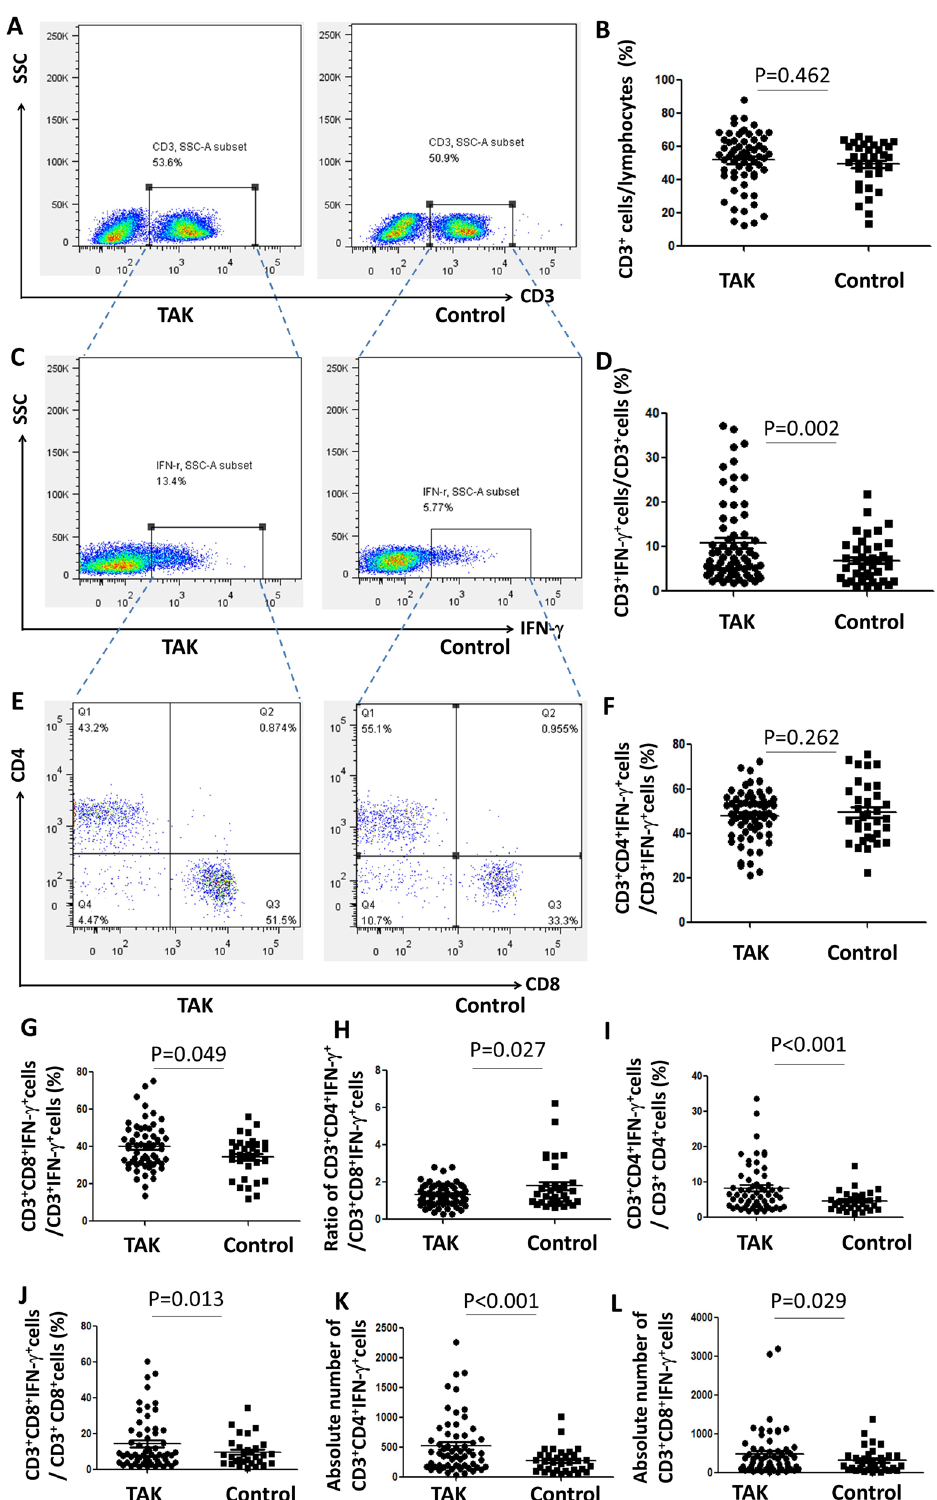
Figure 2. Comparing the proportions of CD3 + CD8 + IFN-γ + cells in CD3 + IFN-γ + cells between the TAK group (n = 60) and the control group (n = 35). ( A,B ) The proportion of CD3 + cells in lymphocytes in TAK group and control group ( P = 0.462). ( C,D ) The proportion of CD3 + IFN-γ + cells in CD3 + cells in TAK group and control group ( P = 0.002). ( E–G ) The proportion of CD3 + CD4 + IFN-γ + cells ( P = 0.262) and CD3 + CD8 + IFN-γ + cells ( P = 0.049) in CD3 + IFN-γ + cells between two groups. ( H ) The ratio of CD3 + CD4 + IFN-γ + / CD3 + CD8 + IFN-γ + in the TAK group and control group ( P = 0.027). ( I ) The CD3 + CD4 + IFN-γ + cells in CD3 + CD4 + cells between two groups ( P < 0.001). ( J ) The CD3 + CD8 + IFN-γ + cells in CD3 + CD8 + cells between two groups ( P = 0.013). ( K ) The absolute number of CD3 + CD4 + IFN-γ + cells between two groups ( P < 0.001). ( L ) The absolute number of CD3 + CD8 + IFN-γ + cells between two groups ( P =